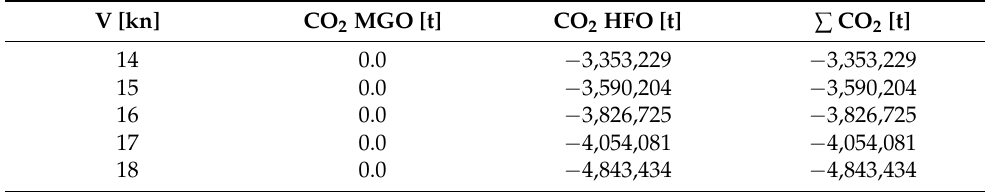
Table 14. Changes in estimated amounts of CO 2 emissions generated by container shipping under global cap conditions as compared to